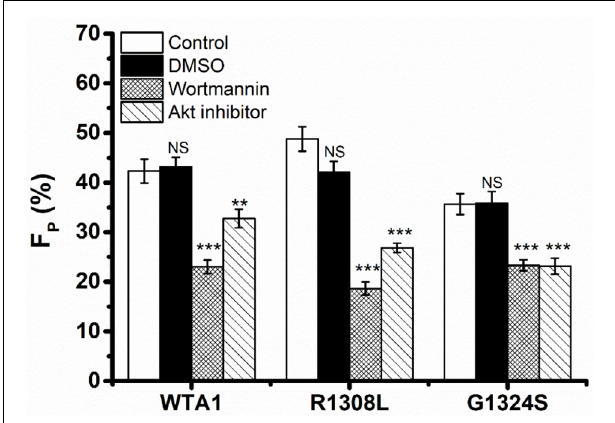
FIGURE 3 | Effects of inhibition to PI3K and Akt on von Willebrand factor (VWF)-induced P-selectin translocation in flows. Fractions of P-selectin-positive inhibitor-treated or untreated platelets on VWF-A1 and its two mutants (R1308L and G1324S). The dimethyl sulfoxide group was from vehicle control experiments, but in the control and inhibitor groups, the P-selectin-positive platelets were treated without (blank column) inhibitor and with either wortmannin or Akt1/2 kinase inhibitor. Data of F P (fraction of P-selectin-positive platelets) were from the independent inhibition experiments thrice under a fluid shear stress of 10 dyn/cm 2 for a stimulus time of 8 min. All data are shown as the mean ± SEM and analyzed by one-way ANOVA for multiple comparisons. ** p < 0.01, *** p < 0.001; NS, not significant compared with the respective control